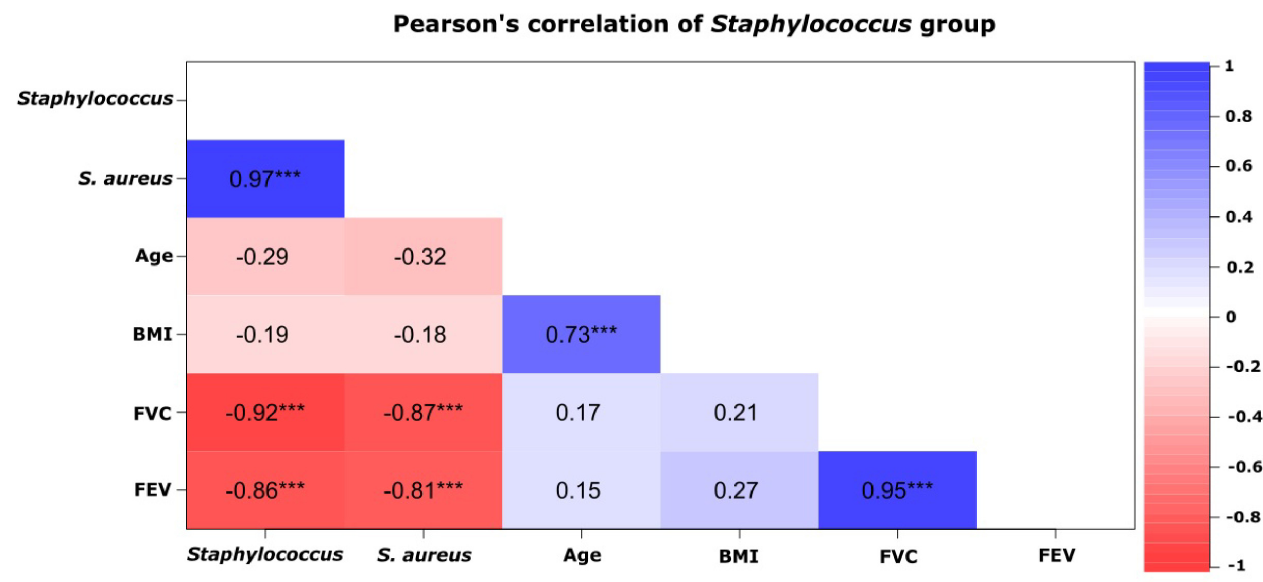
Fig 4. Pearson’s correlation showing significant correlations ( P < 0.05) between microbiota and clinical variables in the Staph group. Asterisks represent significant correlations. The bar in the right shows the correlation type, with positive in blue and negative in red. A positive correlation means that two variables in the matrix increased, n =